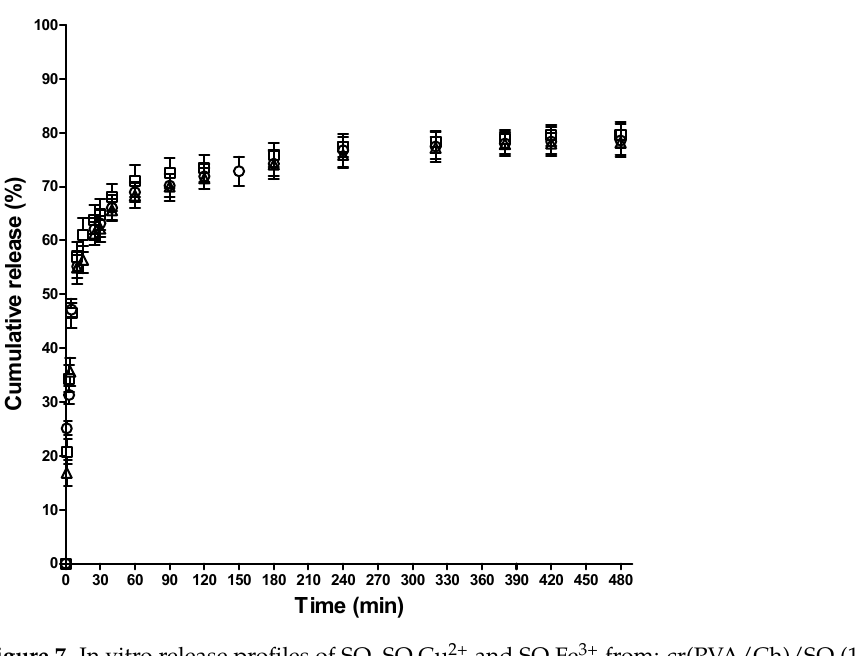
Figure 7. In vitro release profiles of SQ, SQ.Cu 2+ and SQ.Fe 3+ from: cr(PVA/Ch)/SQ (10 wt% SQ) mat ( □ ), Cu 2+ complex of cr(PVA/Ch)/SQ (10 wt% SQ) mat (o) and Fe 3+ complex of cr(PVA/Ch)/SQ (10 wt% SQ) mat ( Δ ) in PBS/Tween 40 (99/1 v / v ) at 37 °C, pH 7.4, ionic strength 0.1. Error bars corre- sponding to the ±SD values calculated based on three replicates for each point.